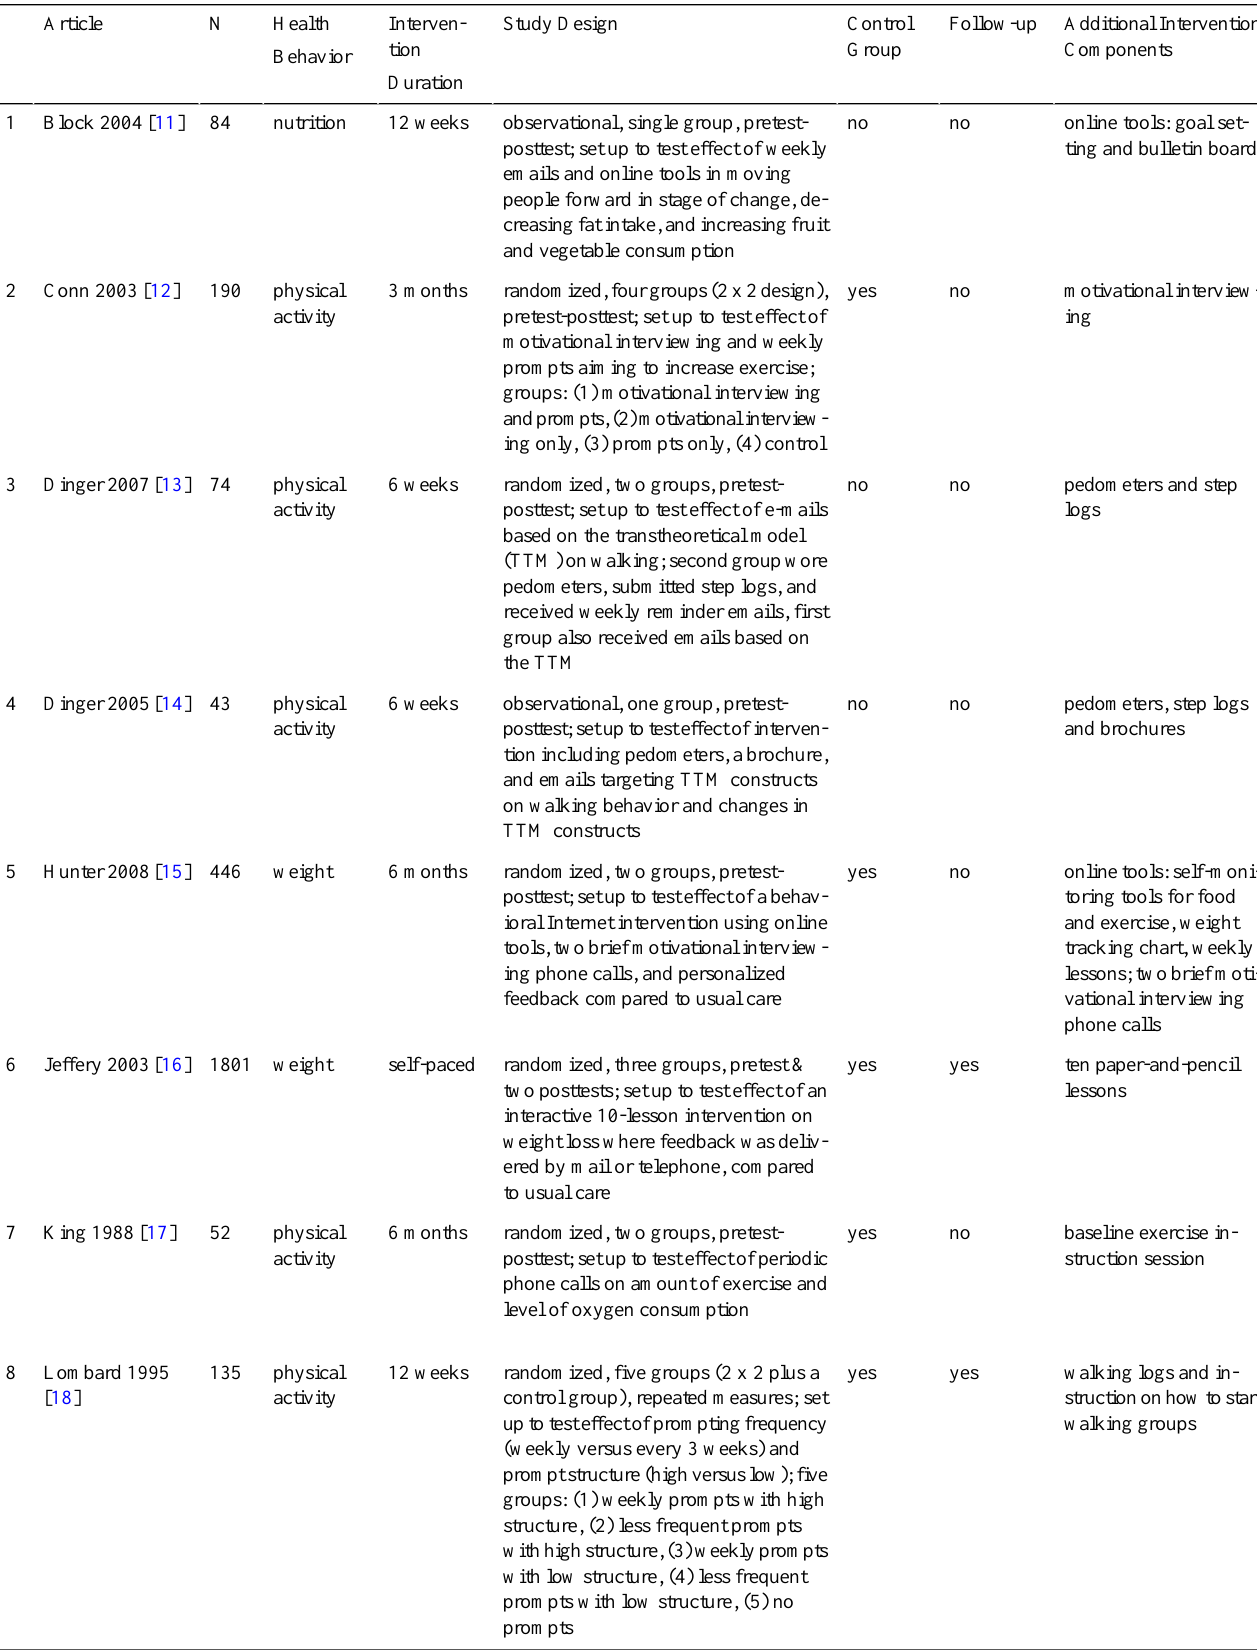
Table 2. Study characteristics